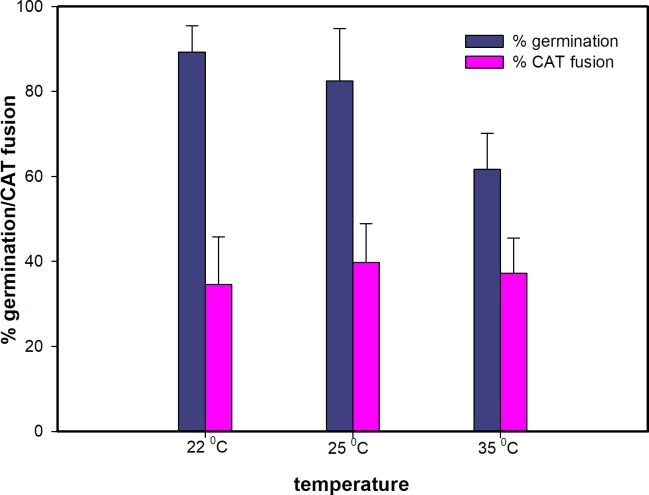
Influence of temperature on microconidial germination and CAT fusion in 1% PDB + 25 mM NaNO3.With the exception of a ~15% reduction in germination at 35°C, the three temperatures tested had no significant influence on the percentage of spore germination or CAT fusion. 1x106 spores/ml were used.